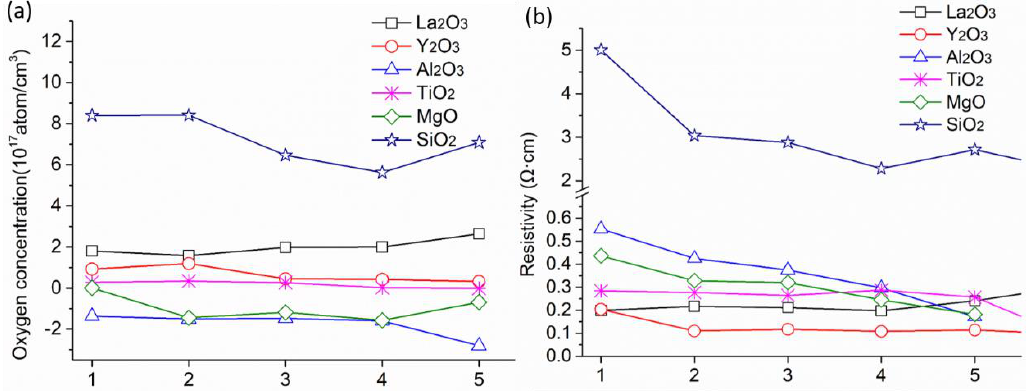
Figure 11. ( a ) Vertical O concentration and ( b ) electrical resistivity distributions of Si pieces away from the interface of the Si/SiO 2 – ceramic additives.